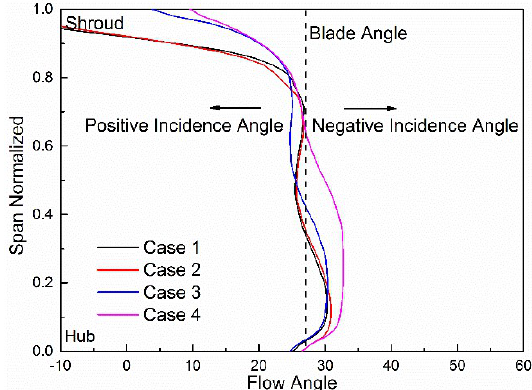
Table 2. The average incidence angle of dry and wet compression at diffuser inlet